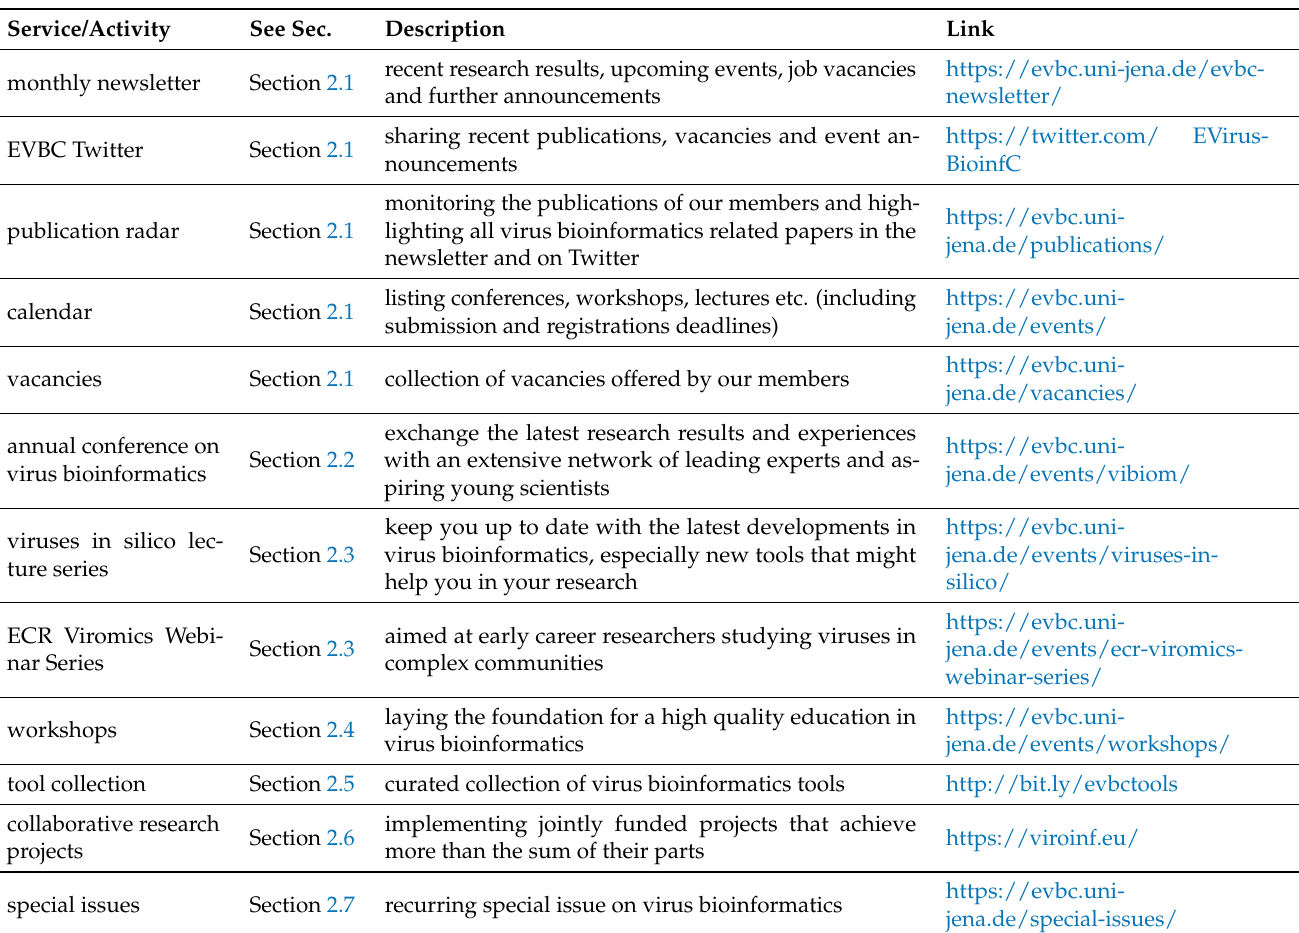
Table 1. EVBC services and activities. The EVBC is engaging in several activities to solidify the exchange of ideas, initiate scientific cooperation between bioinformaticians and virologists and increase the international visibility of virus bioinformatics. If you are interested in joining the EVBC, please fill in the application form